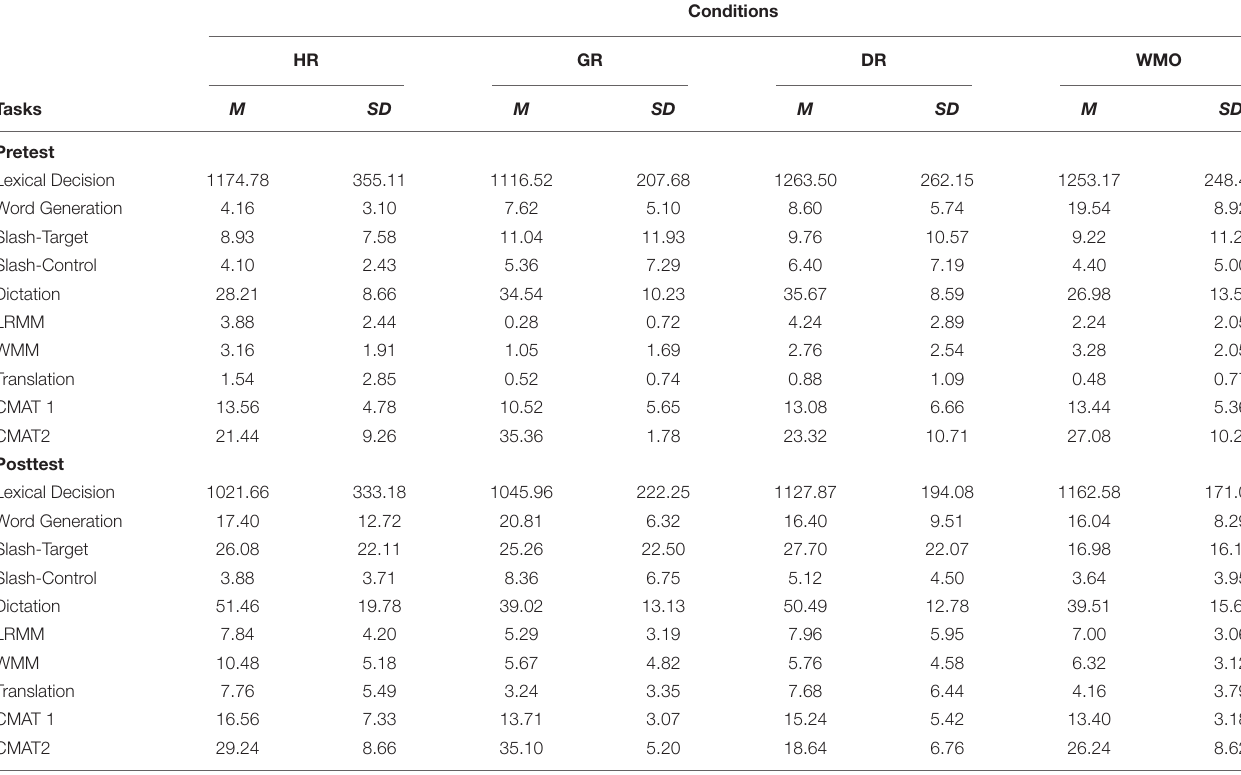
TABLE 1 | Descriptive statistics of all measures in 10 assessments between four conditions.